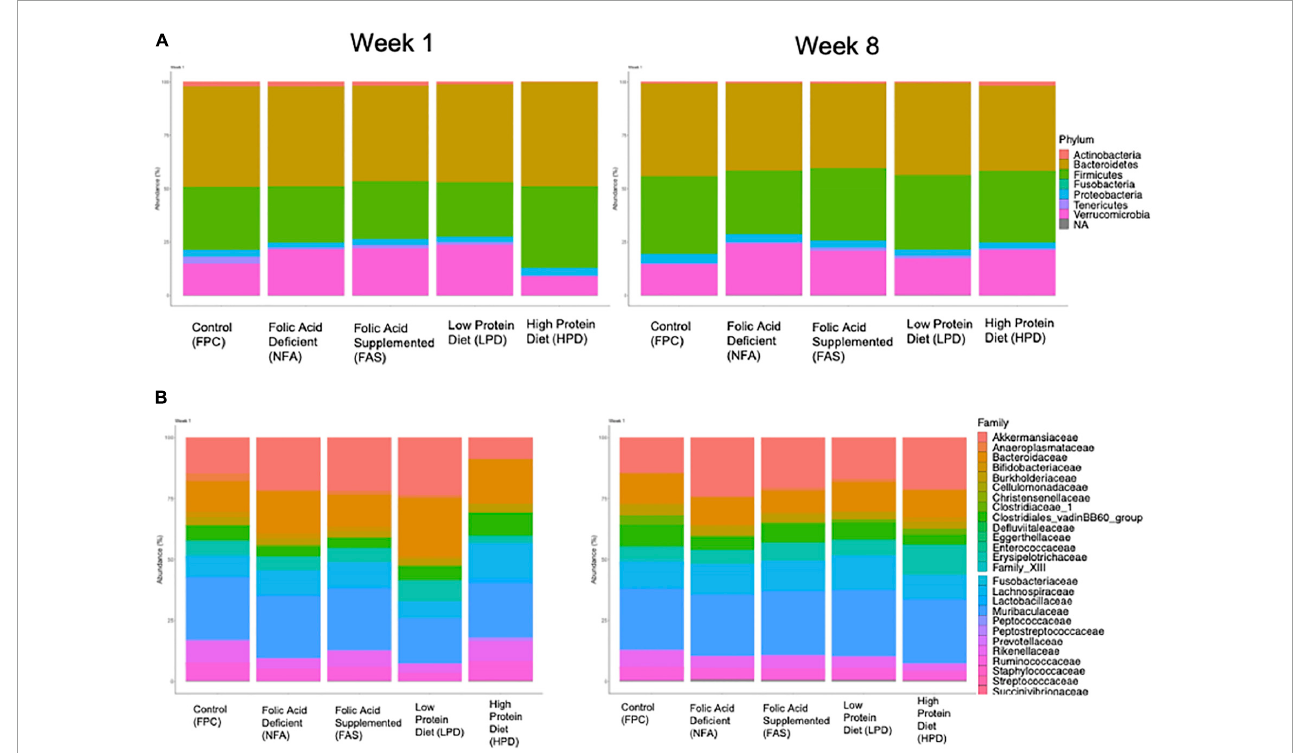
FIGURE6 Relative (A) phylum and (B) family abundance of the fecal microbiota across diets. All ASVs were included in an analysis of percent phylum and family level abundance across diets at weeks 1 and 8. Colors correspond to taxa represented in each legend and the size of the boxes on the bar graphs indicates relative percent abundance of that